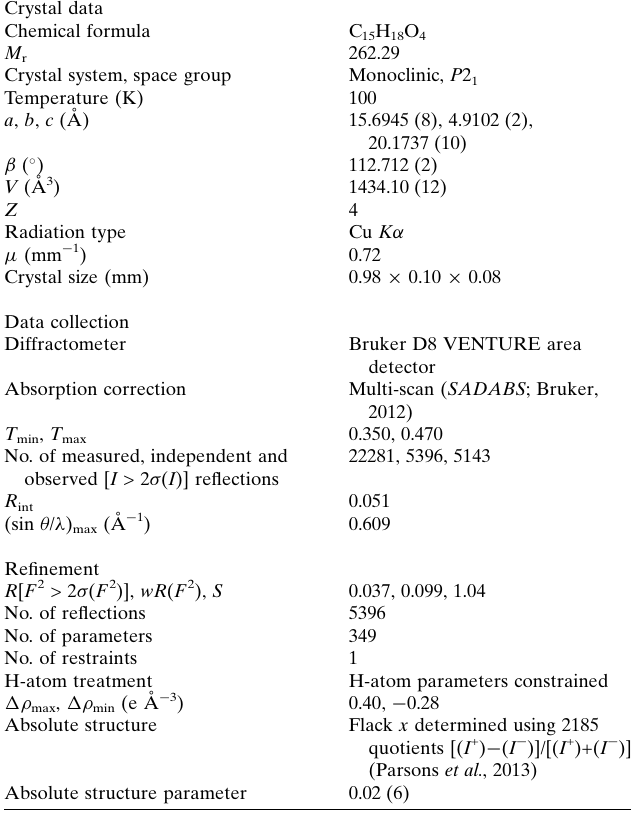
Table 2 Experimental details. Crystal data Chemical formula